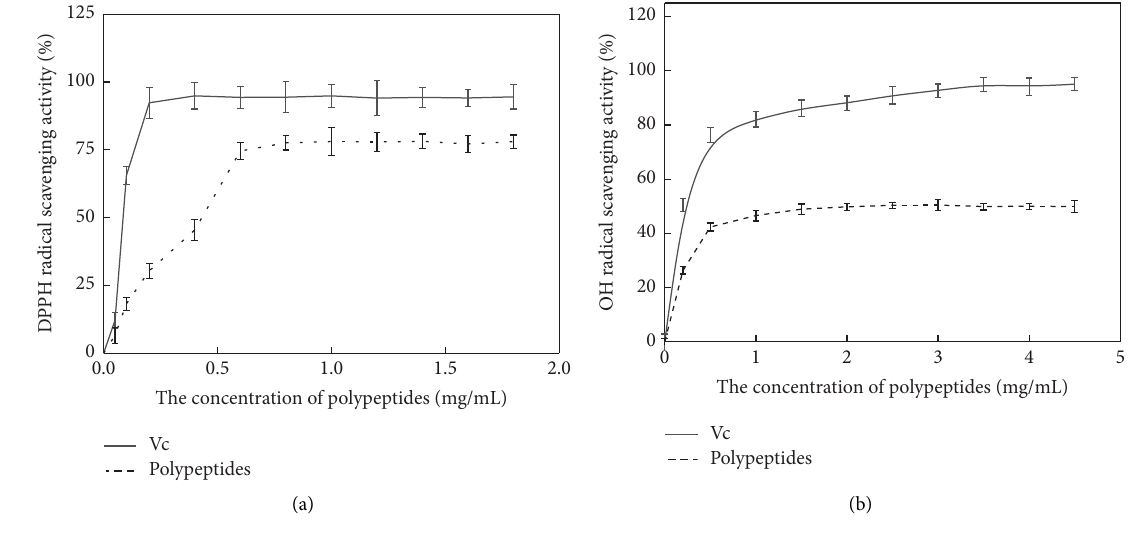
Figure 5: Scavenging rate of polypeptide in C. militaris to DPPH • (a) and • OH (b). Table 6: Bacteriostatic efect of